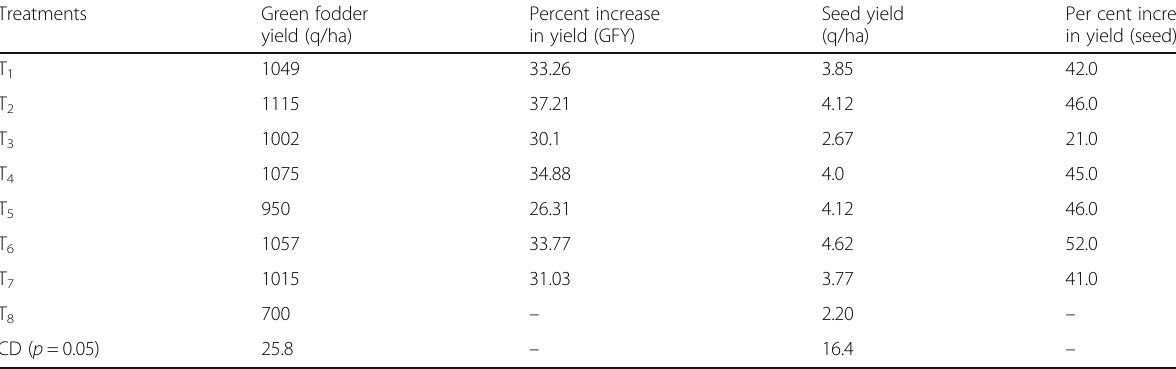
Table 4 Green fodder and seed yield in different treatment combinations Treatments Green fodder Percent increase yield (q/ha) in yield